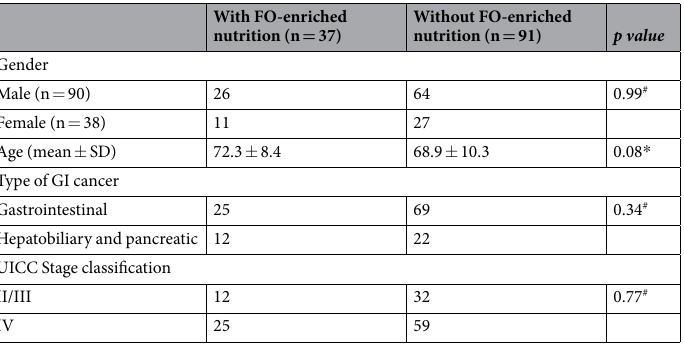
Table 5. Patient characteristics and comparison between clinicopathological factors and treatment course in patients with GI cancer. * Student’s t-test, # Chi-square